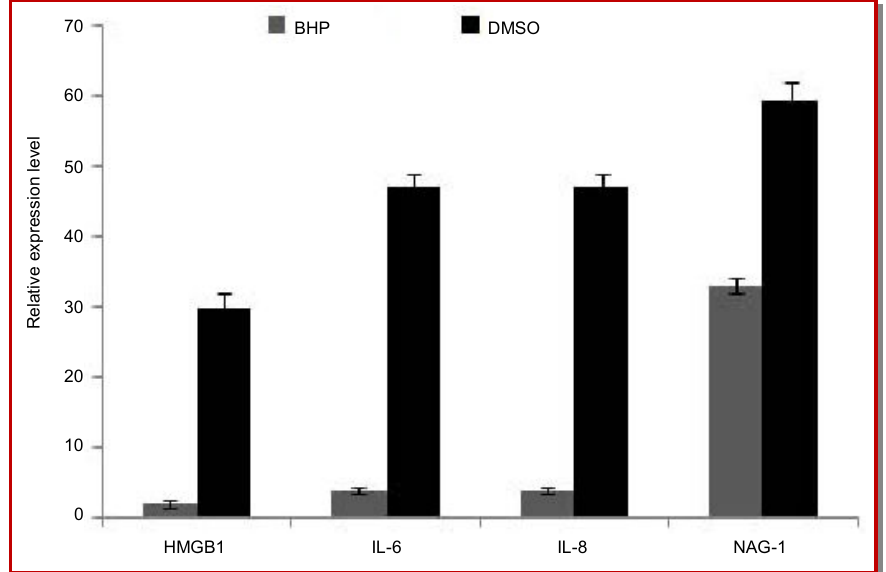
Figure 5: Inhibition of HMGB1, IL-6 and IL-8 expression and promotion of NAG-1 expression by BHP treatment in PC3 cells. The PC3 cells were incubated with BHP or DMSO as the control for 48 hours at 37°C. After incubation, expression levels of HMGB1, IL -6, IL-8 and NAG-1 genes were quantified by real-time